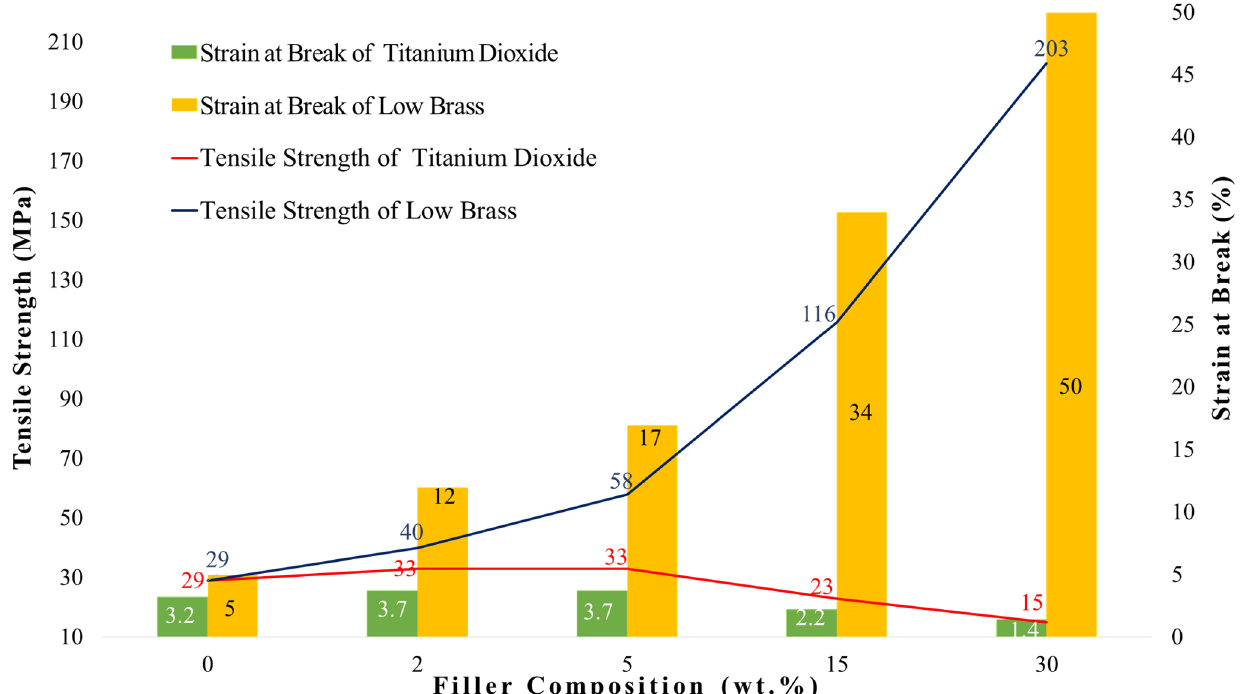
Figure 2. Tensile strength and strain at break for titanium dioxide and low brass fillers.